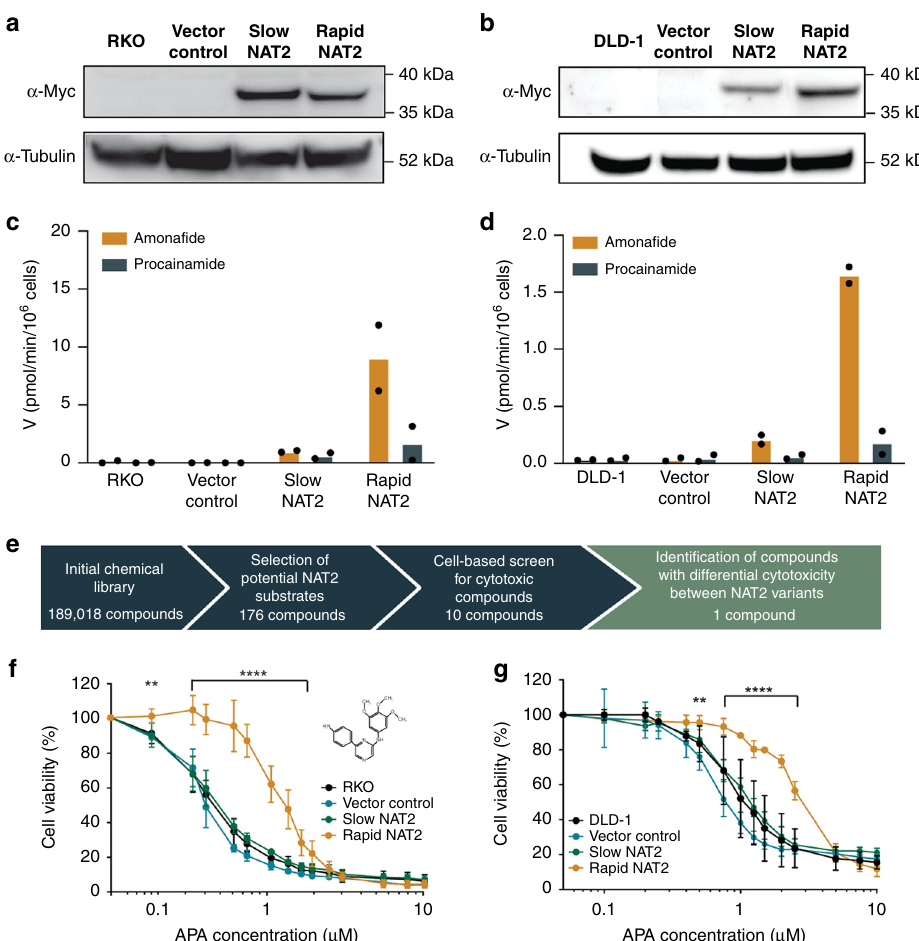
Fig. 2 Identi fi cation of 6-(4-aminophenyl)-N-(3,4,5-trimethoxyphenyl)pyrazin-2-amine (APA), a compound selectively toxic to slow NAT2 cells. a , b Validation of RKO ( a ) and DLD-1 ( b ) CRC cell models of rapid and slow NAT2. Cell lysates from clones and parental cells were subjected to PAGE and immunoblotting with an α -MYC-Tag antibody to detect recombinant NAT2 and α -tubulin detection as loading control. c , d Quanti fi cation of NAT2 catalytic activity in RKO and DLD-1 cell clones. The velocity at which the NAT2-speci fi c substrates amona fi de (yellow) and procainamide (blue) become acetylated by different enzymatic variants at 10 µ M was measured by LC-MS/MS in RKO ( c ) and DLD-1 ( d ) clones. Mean of two independent experiments. e Work fl ow of the selection of the chemical compounds for screening. f , g The dose-response for APA is NAT2 dependent in both RKO ( f ) and DLD-1 ( g ) CRC cells. Rapid or slow acetylator NAT2 clones, parental cells and vector controls were treated with different concentrations of APA and cell viability was measured by MTT assay after 72 h. The mean and S.D. of three independent experiments is shown. Data were analyzed using two-way ANOVA. ** P = 0.0035 in ( f ) and 0.0074 in ( g ), **** P <